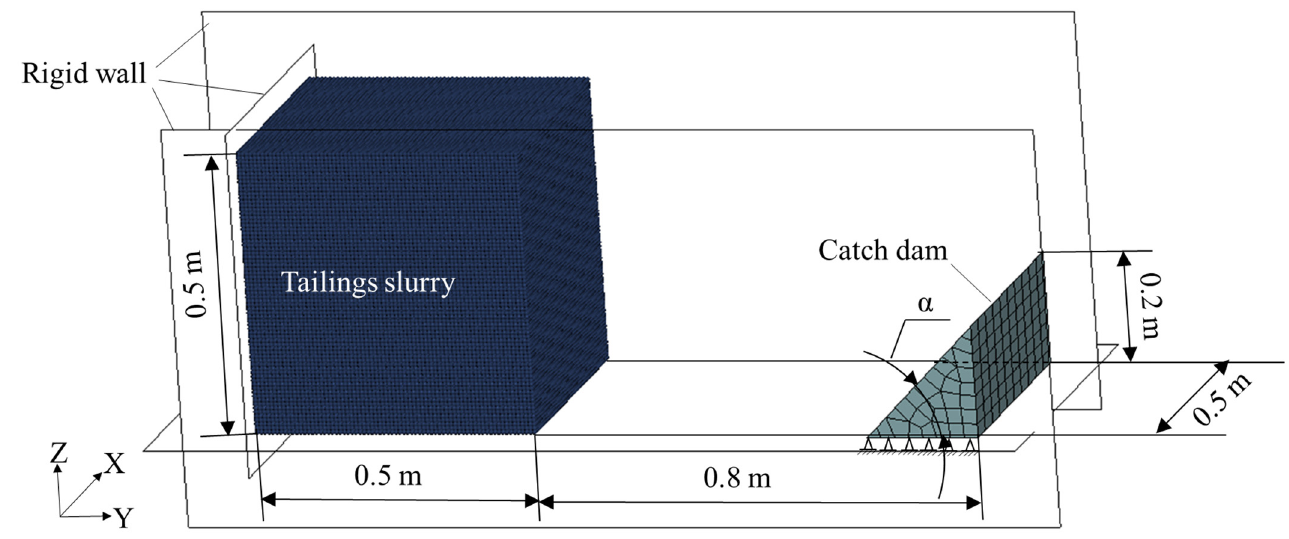
Figure 3. The numerical model and boundary conditions of tailings dam break model.